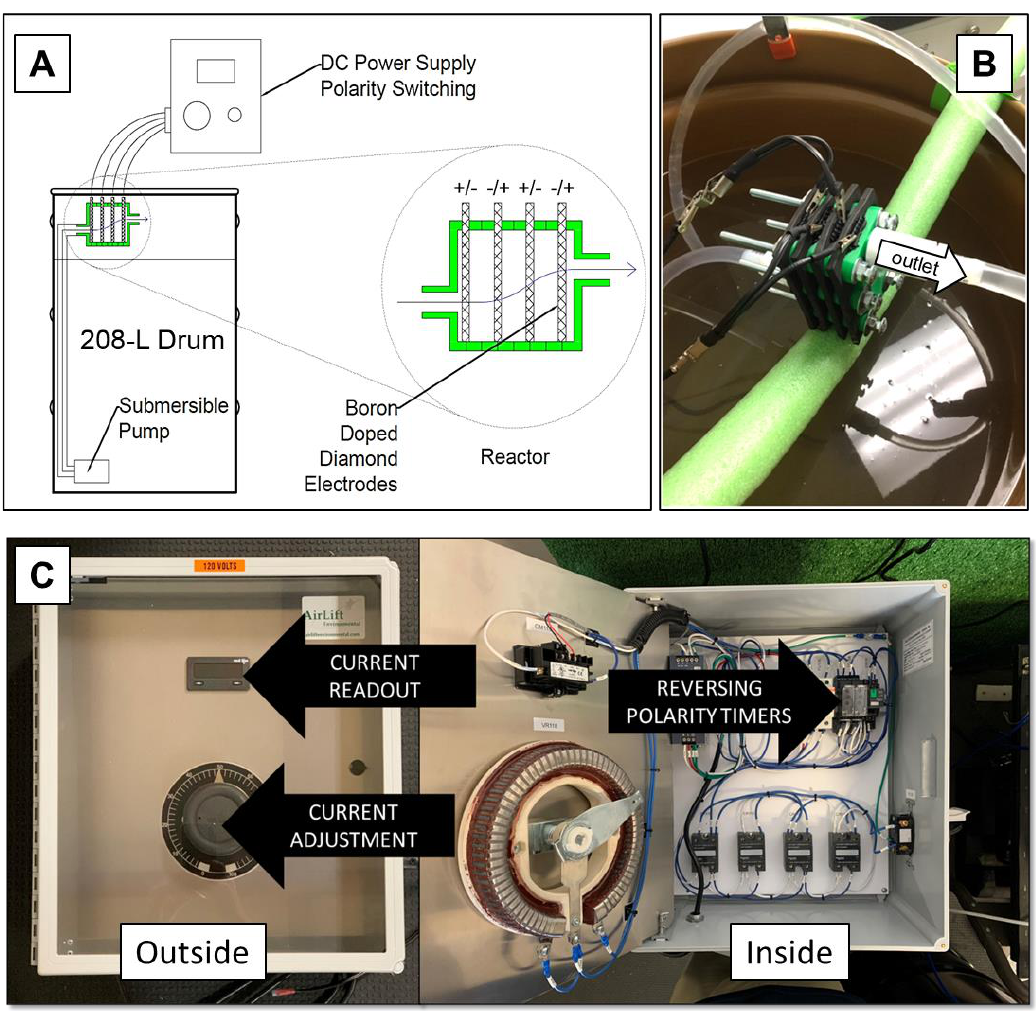
Figure 8. ( A ) Schematic of 208 L barrel experiment with components consisting of barrel, direct- current power supply, and 3D printed, four-BDD electrode chamber; ( B ) photograph of 3D printed electrode chamber; ( C ) photograph of direct current power supply.